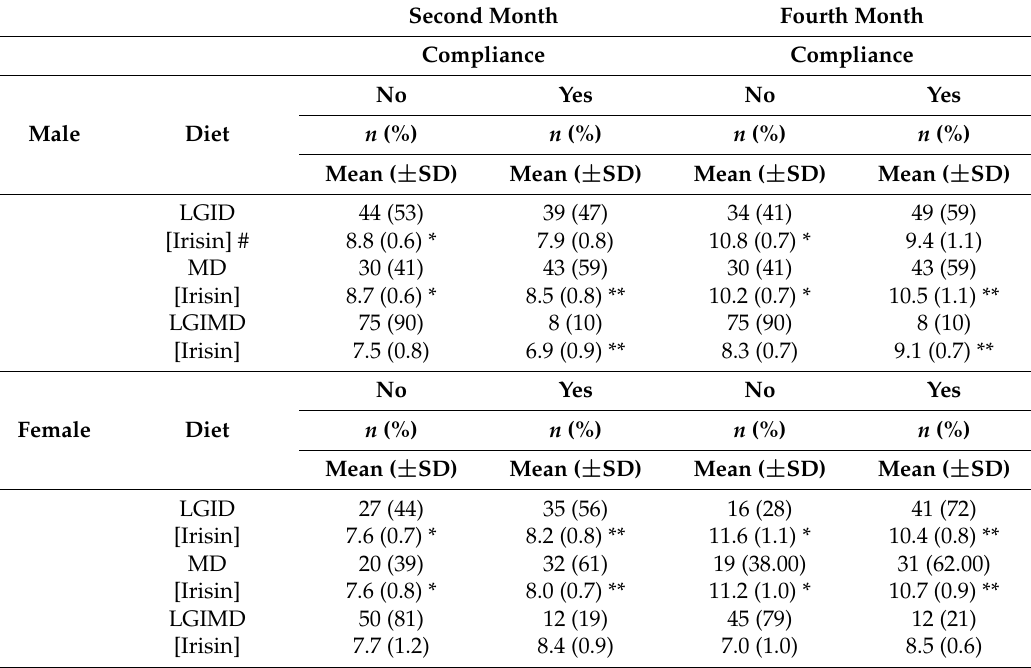
Table 2. Compliance with the Low Glycaemic Index Mediterranean, Mediterranean and Low Glycaemic Index Diet, and Mean irisin level by Gender and